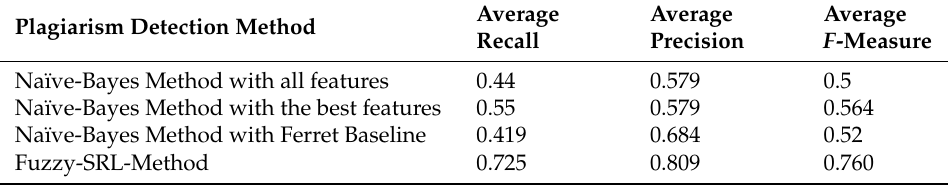
Table 5. Light plagiarism